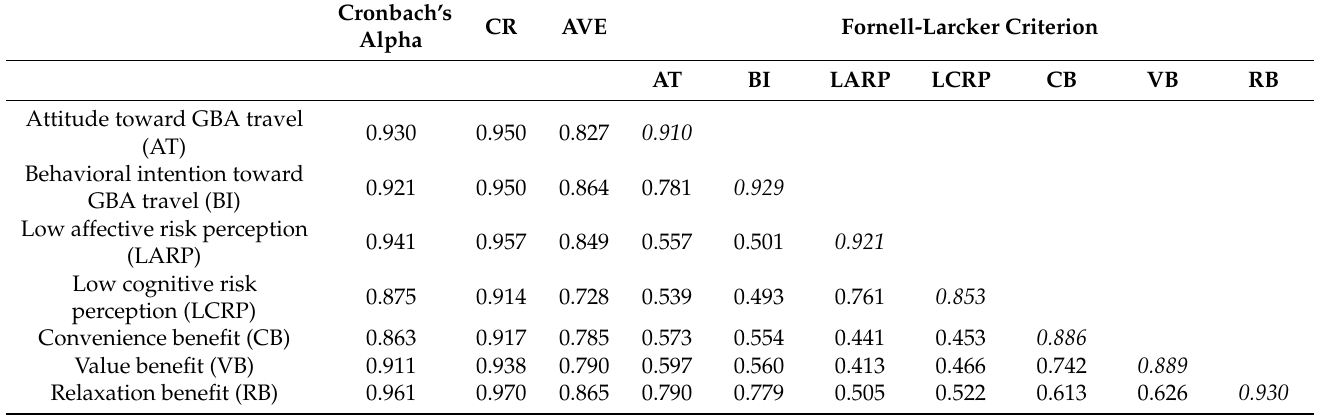
Table 4. Reliability, construct validity, and correlation.